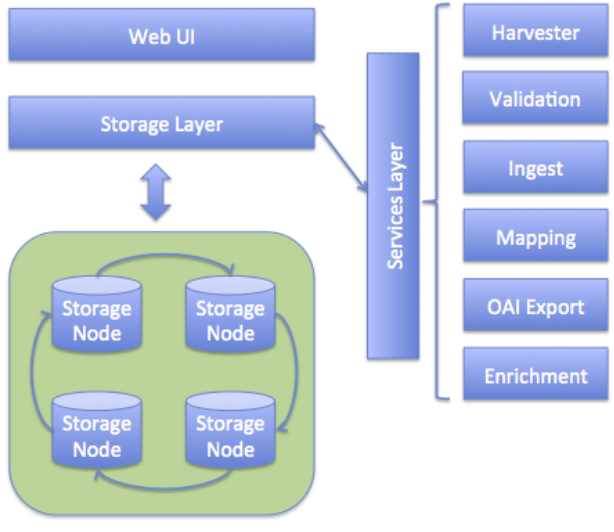
Figure 1. MoRe aggregator